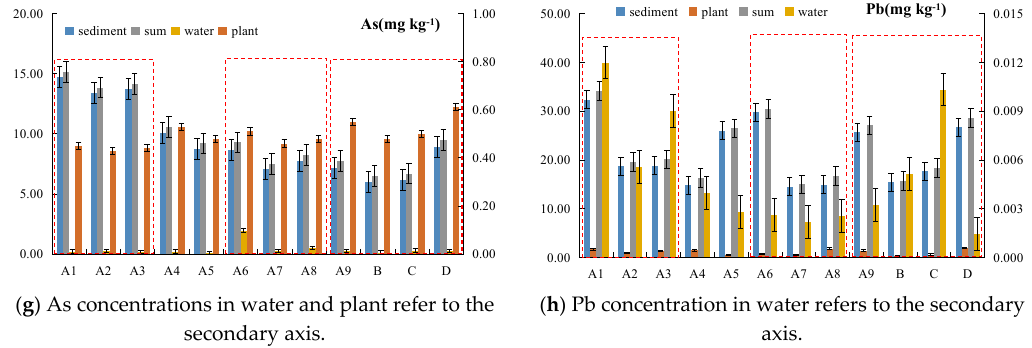
Figure 2. Changes in heavy metal content and pH in sediment, overlying water, and vegetation of various sample plots.